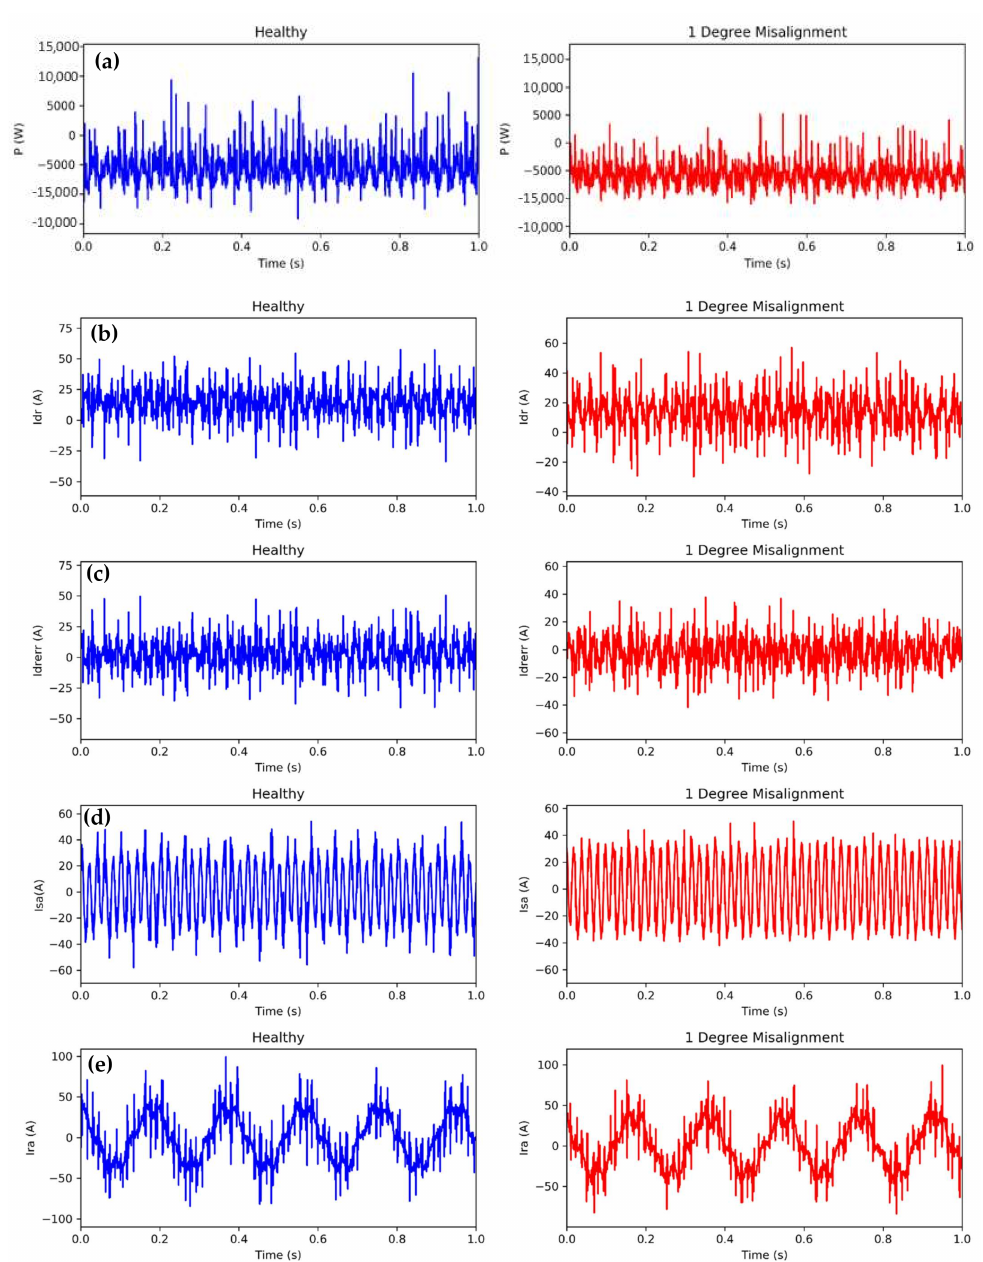
Figure 3. Healthy and one-degree misalignment time domain spectra: controller P ( a ), Idr ( b ), Idrerr ( c ), and terminal Isa ( d ), Ira ( e ) signals at @ 1340 RPM and 50%